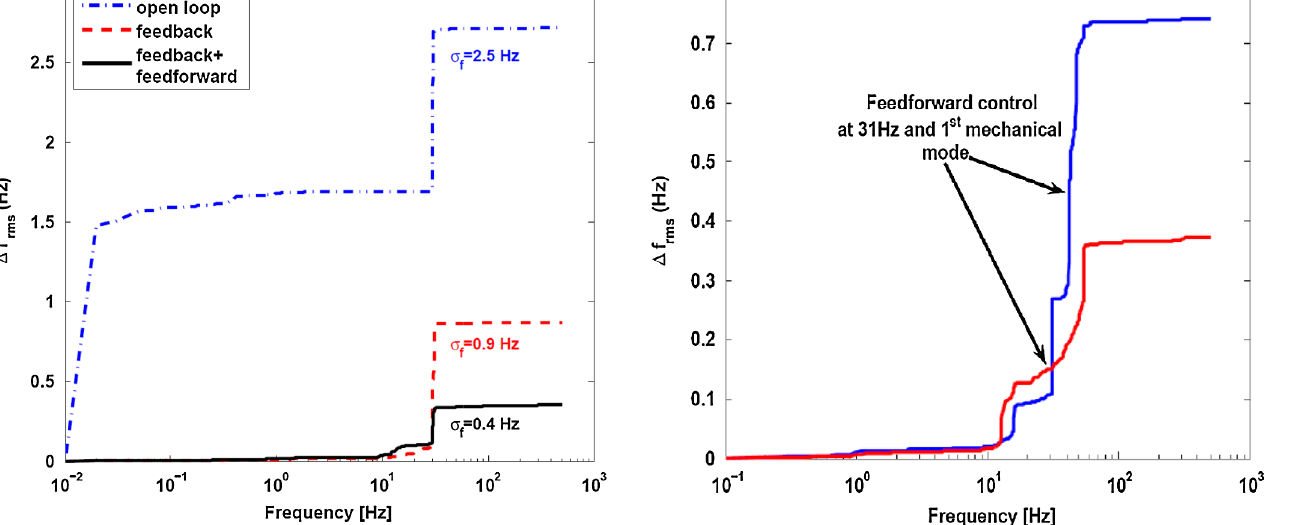
FIG. 18. (Color) Integrated detuning spectra of feedback con- trolled detuning (blue curve) and feedback þ feedforward con- trolled detuning (red curve) at two nearby mechanical excitations of 31 and 41 Hz.